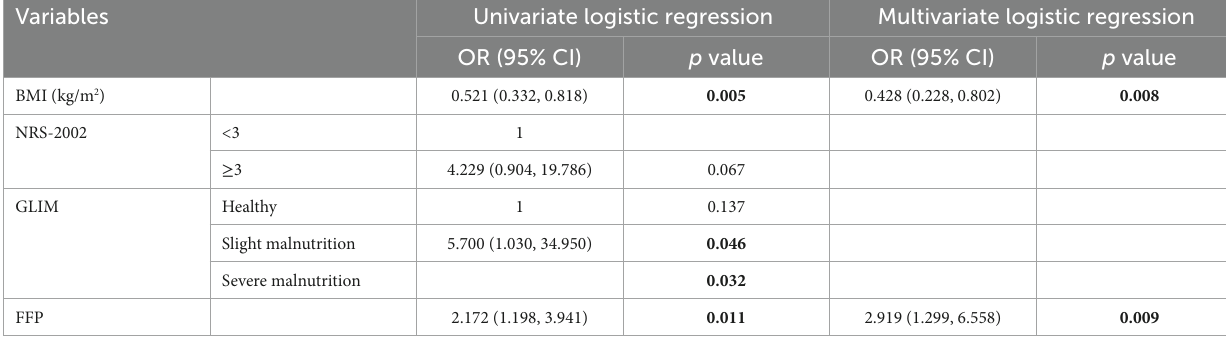
TABLE 6 Univariate and multivariate logistic regression analysis for subjects <65 years old.